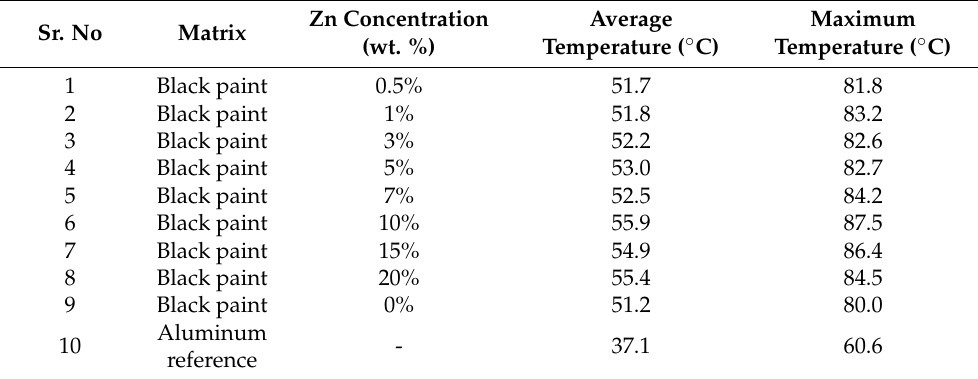
Table 3. Summary of outdoor analysis for maximum temperature and average